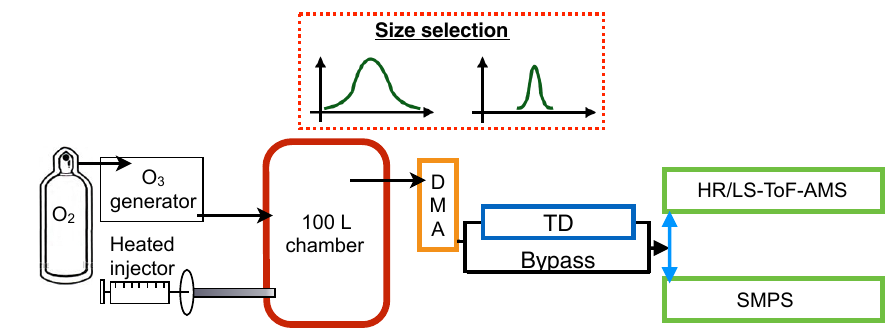
Figure 1. Experimental setup for SOA CE experiments.